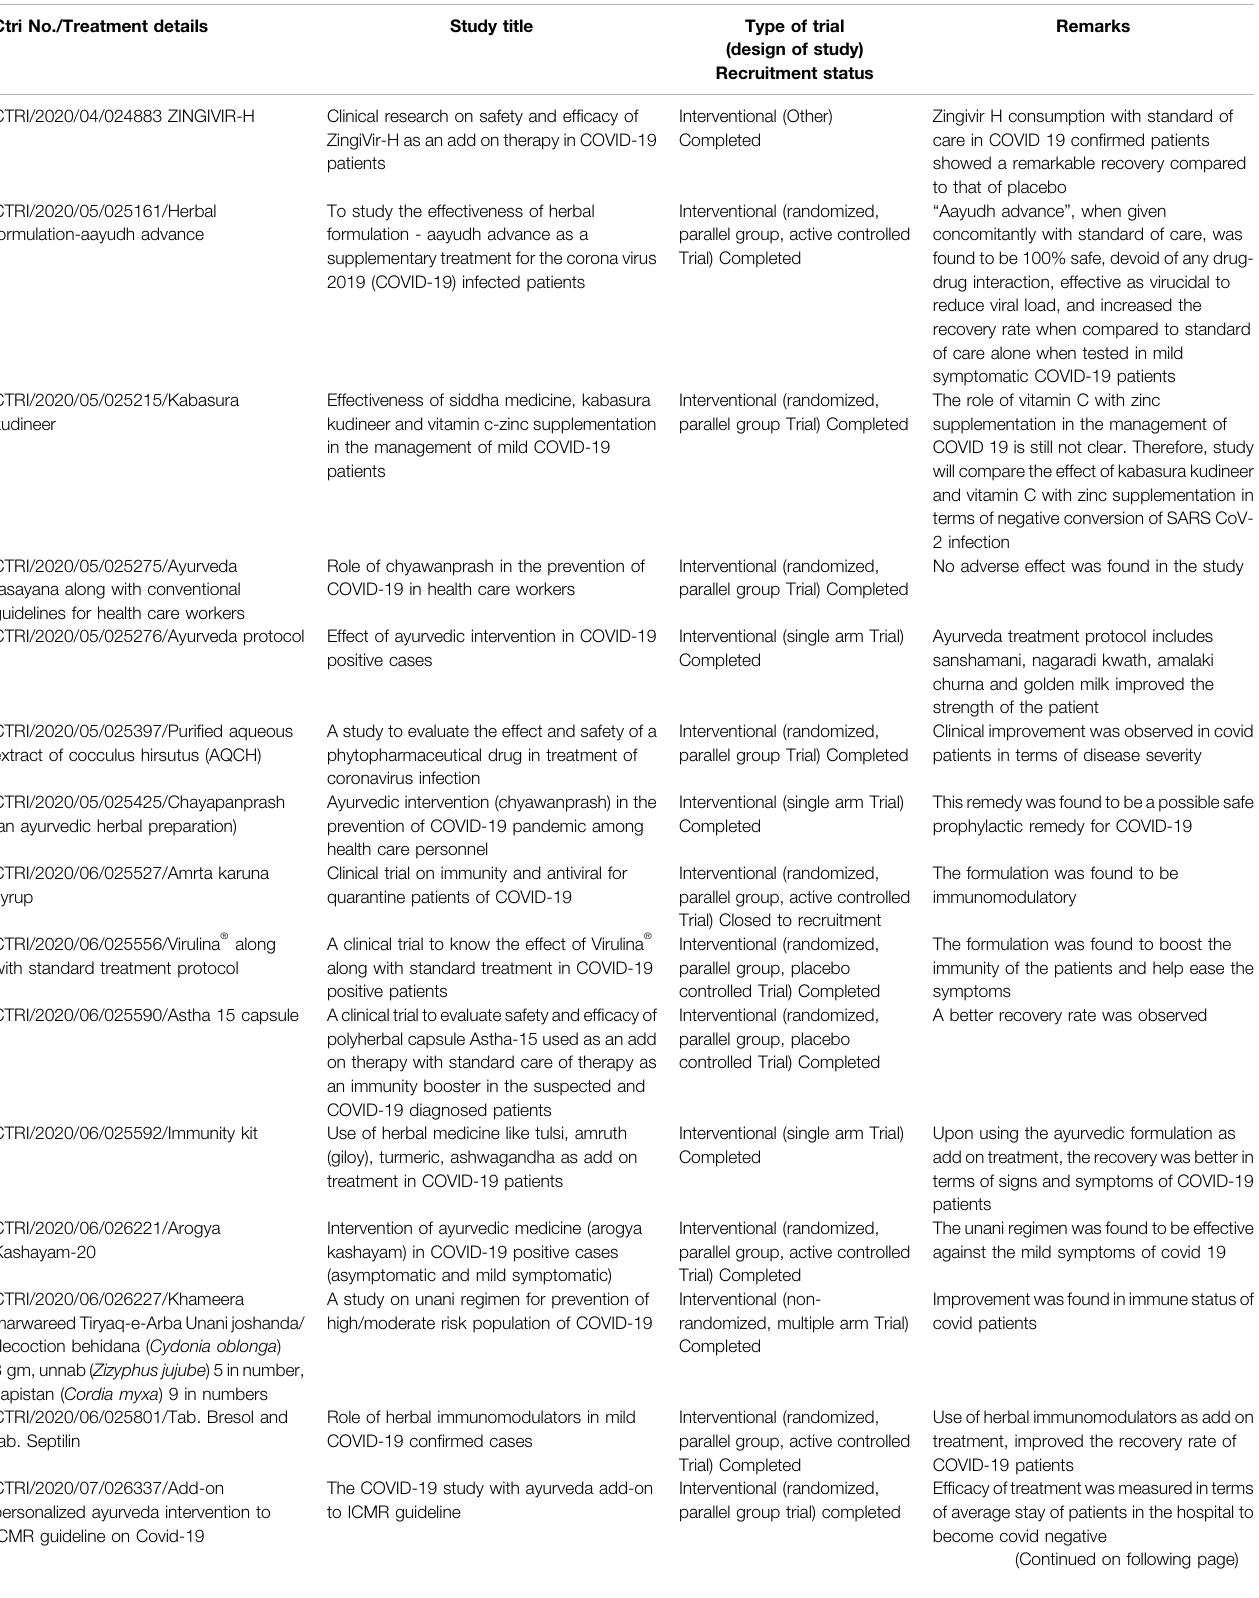
TABLE 1 | Details of clinical trials completed on AYUSH drugs for COVID-19 (Source: www.ctri.nic.in). Ctri No./Treatment